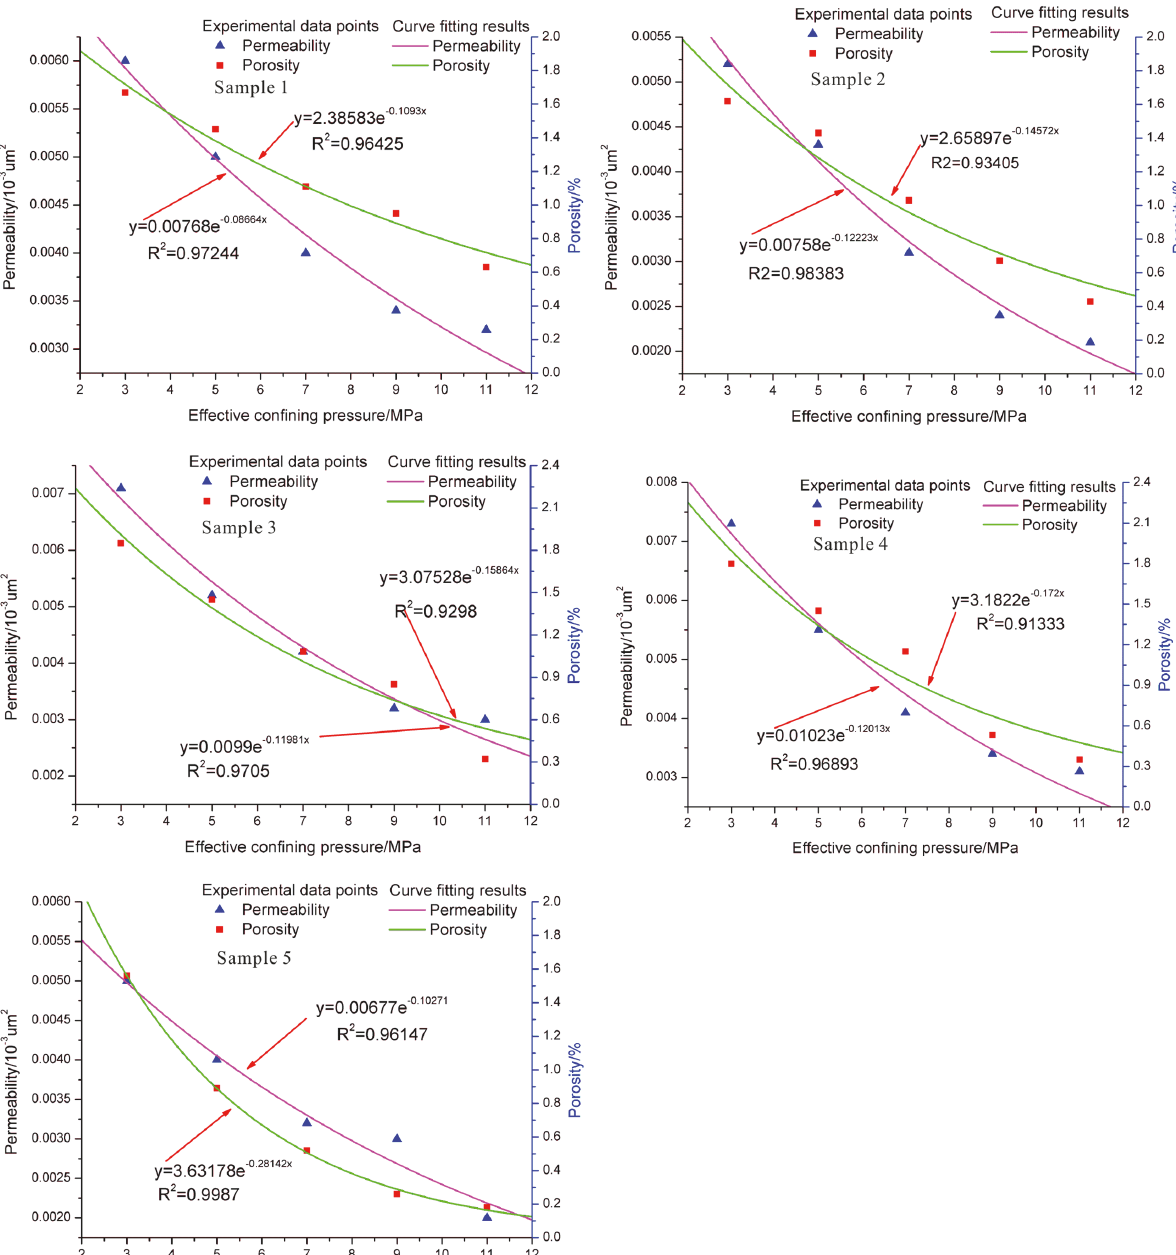
Figure 1: Relationships of the permeability and porosity with the effective confining pressure of shale.